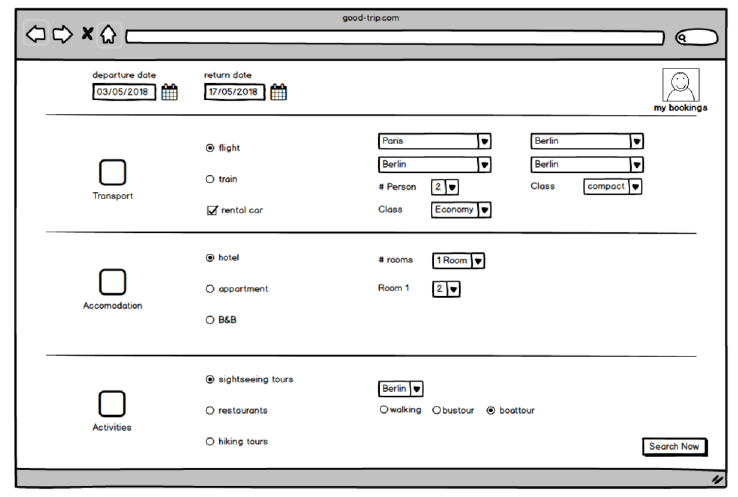
Figure 9. Low-fidelity prototype screen